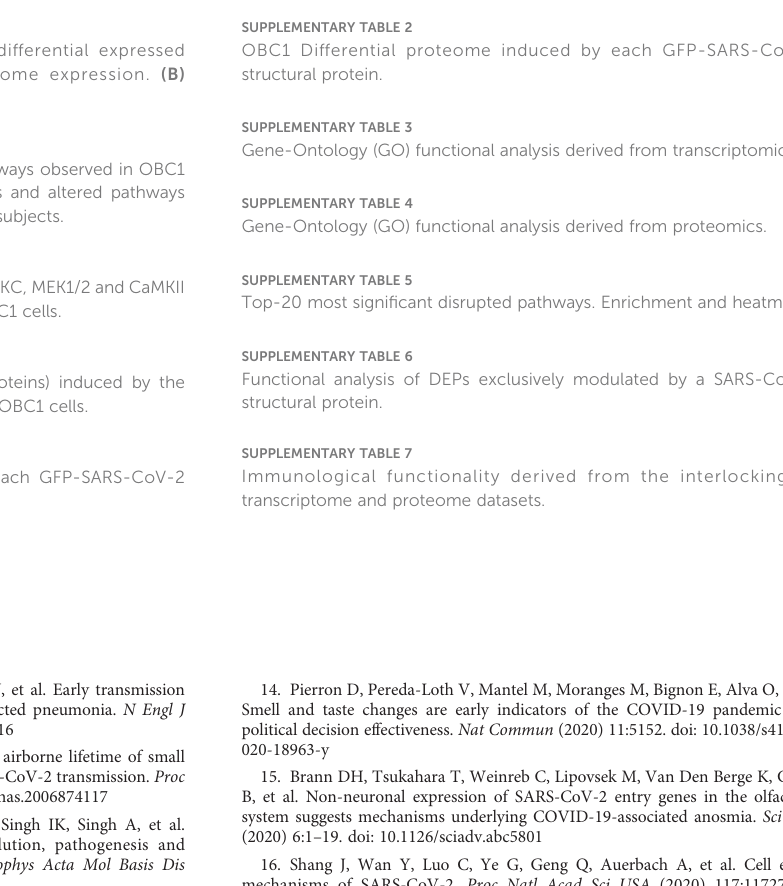
Gene-Ontology (GO) functional analysis derived from transcriptomics.